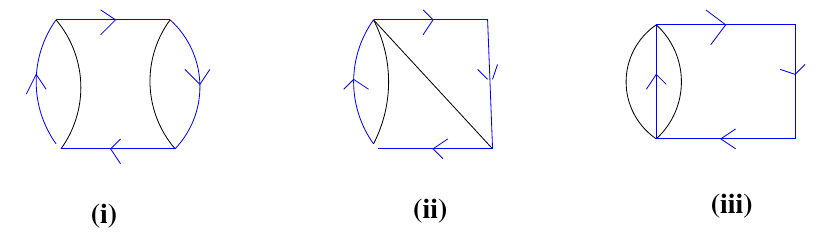
Figure 5 . (i) Q 12 , (ii) Q 13 and (iii) Q 14 .